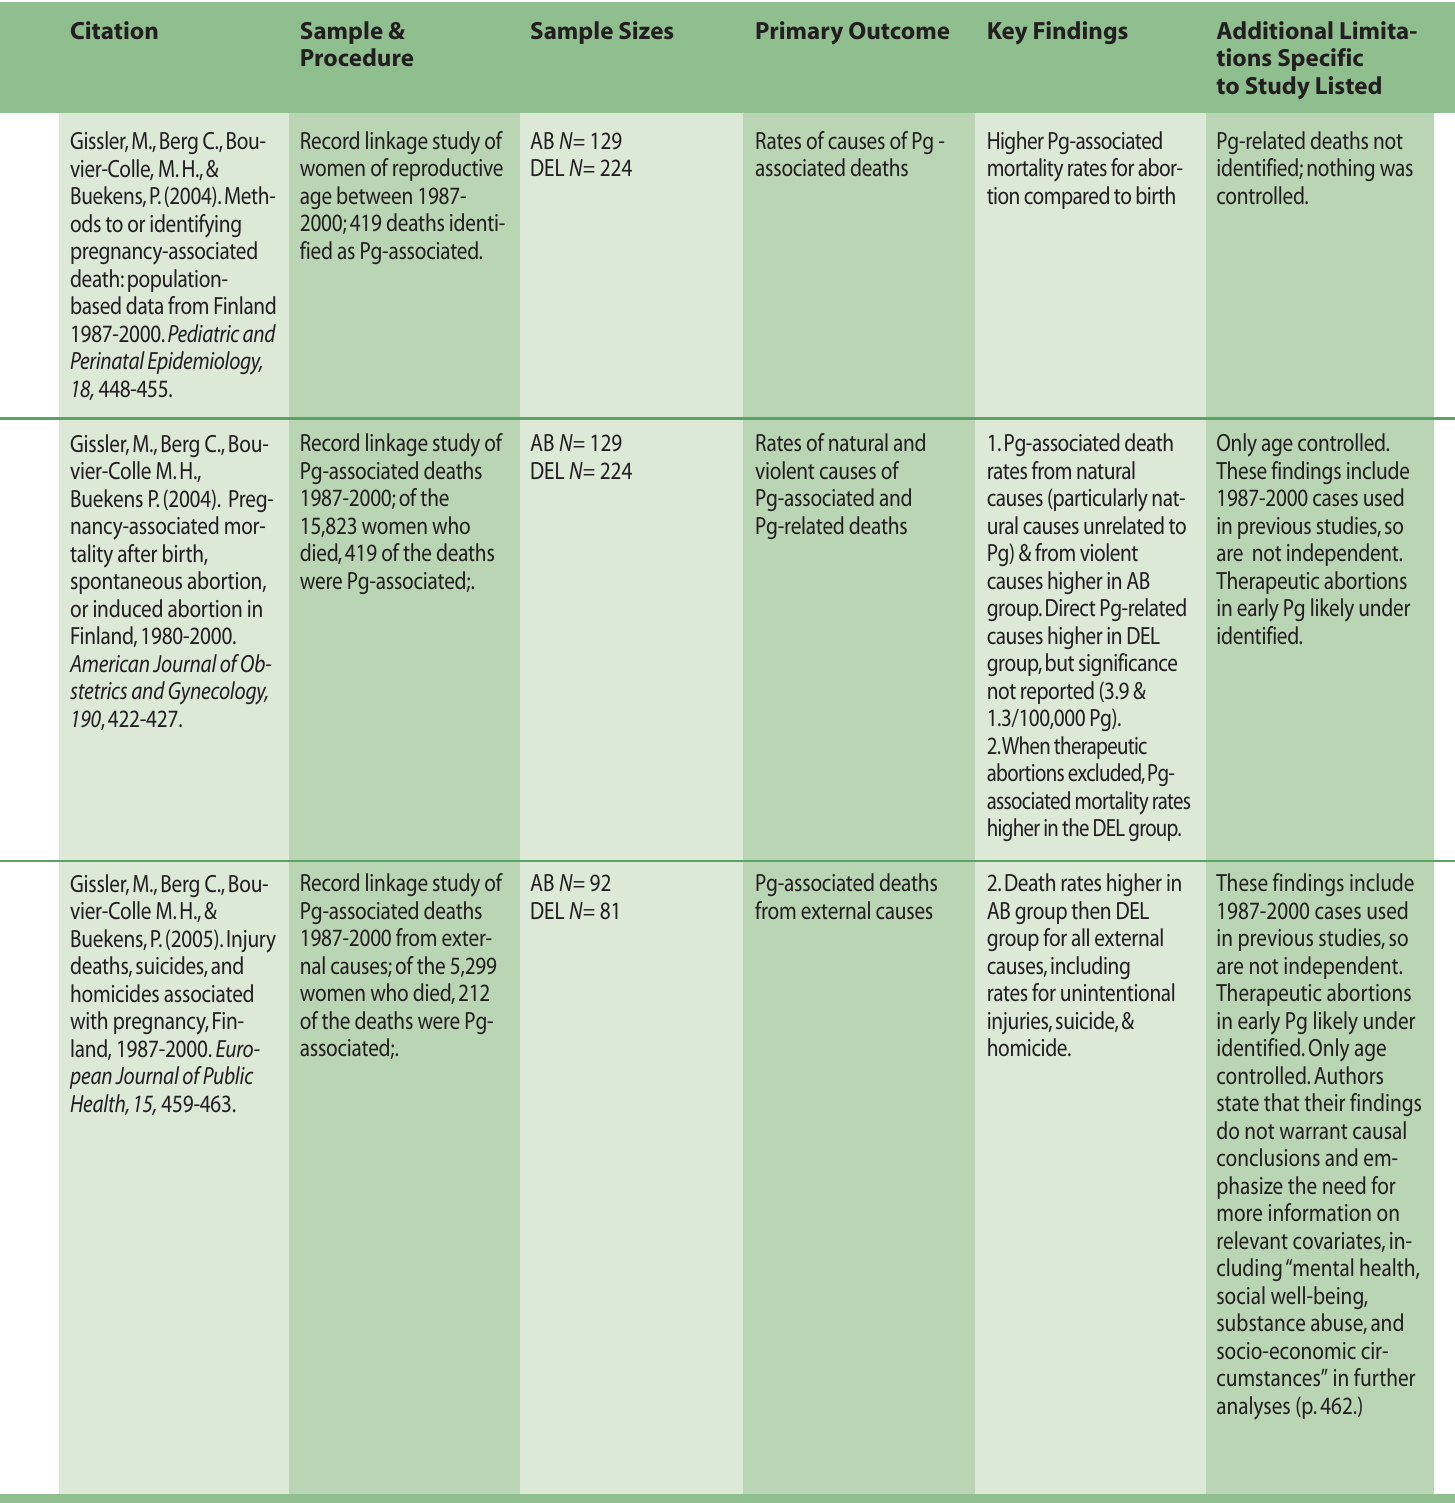
Table 1: Medical Records–Abortion vs.Comparison